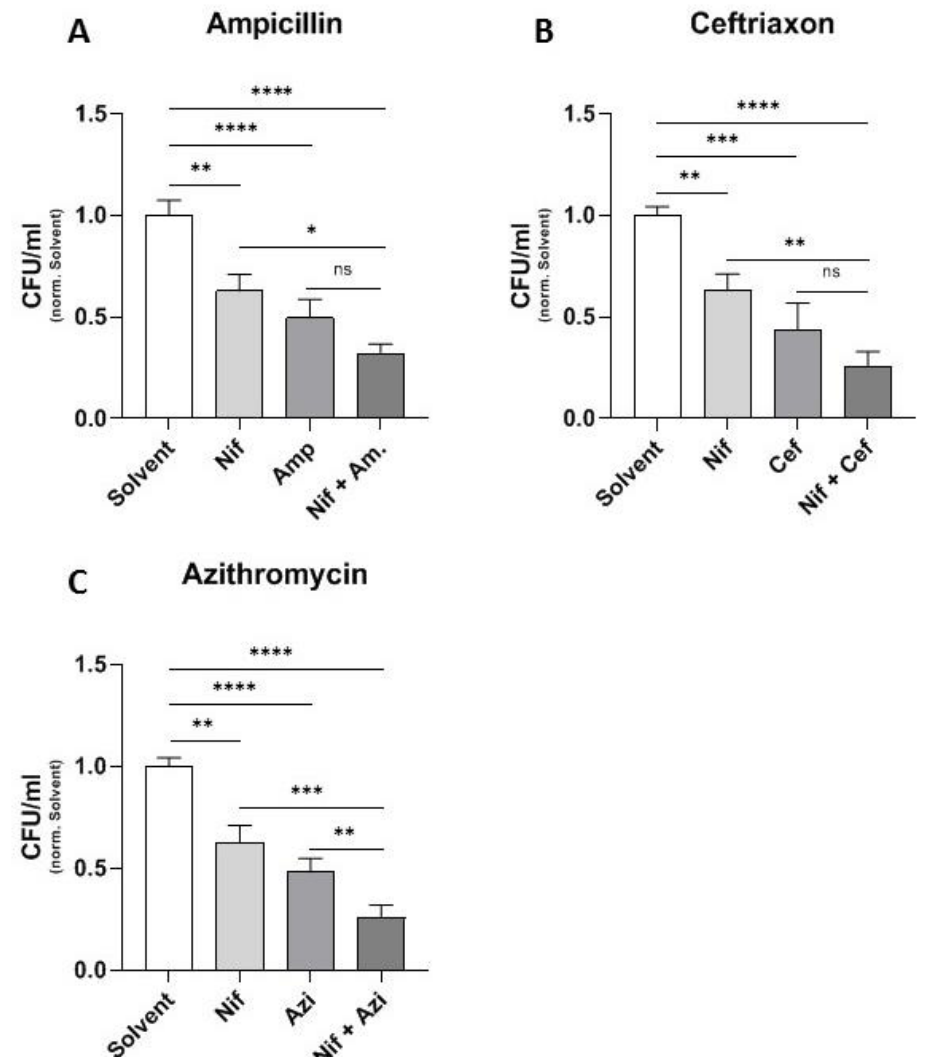
Figure 1. Different antibiotics in combination with nifedipine. RAW264.7 cells were infected with Salmonella Typhimurium for 24 h and treated with 17. 3 μg/m L nifedipine (Nif) as well as one of the indicated antibiotics: ampicillin (Amp, 0. 07 μg/m L) ( A ), ceftriaxon (Cef, 0. 005 μg/m L) ( B ) or azithromycin (Azi, 0. 3 μg/m L) ( C ). Data are expressed as mean ± SEM of at least four independent experiments. Superscripts indicate statistical significance as follows: * p < 0.05, ** p < 0.01, *** p < 0.001, **** p < 0.0001.